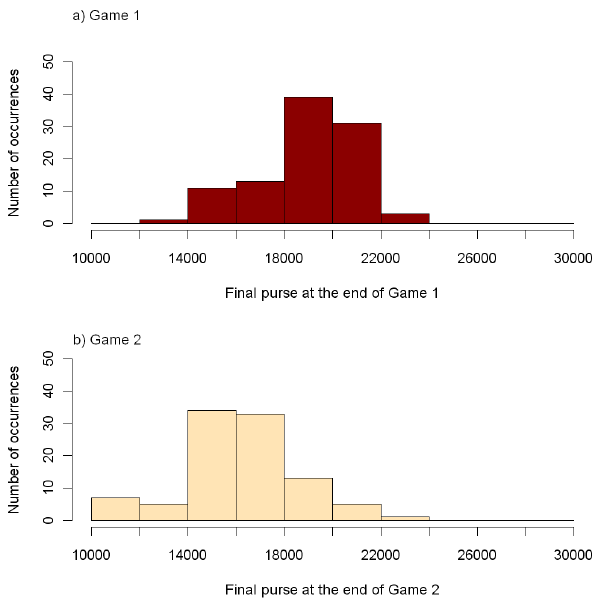
Fig. 7. Histograms of final purses at the end of Game 1 with un- certainty information (top panel) and at the end of Game 2 without Figure 7. Histograms of final purses at the end of Game 1 with uncertainty information 3 uncertainty information (bottom panel) computed over 98 partici- (top) and at the end of Game 2 without uncertainty information (bottom) computed 4 over 98 participants. Initial purse was 30000. Histograms cells are right-closed (left 5 pants. Initial purse was 30000. Histograms cells are right-closed open) intervals. 6 (left open)